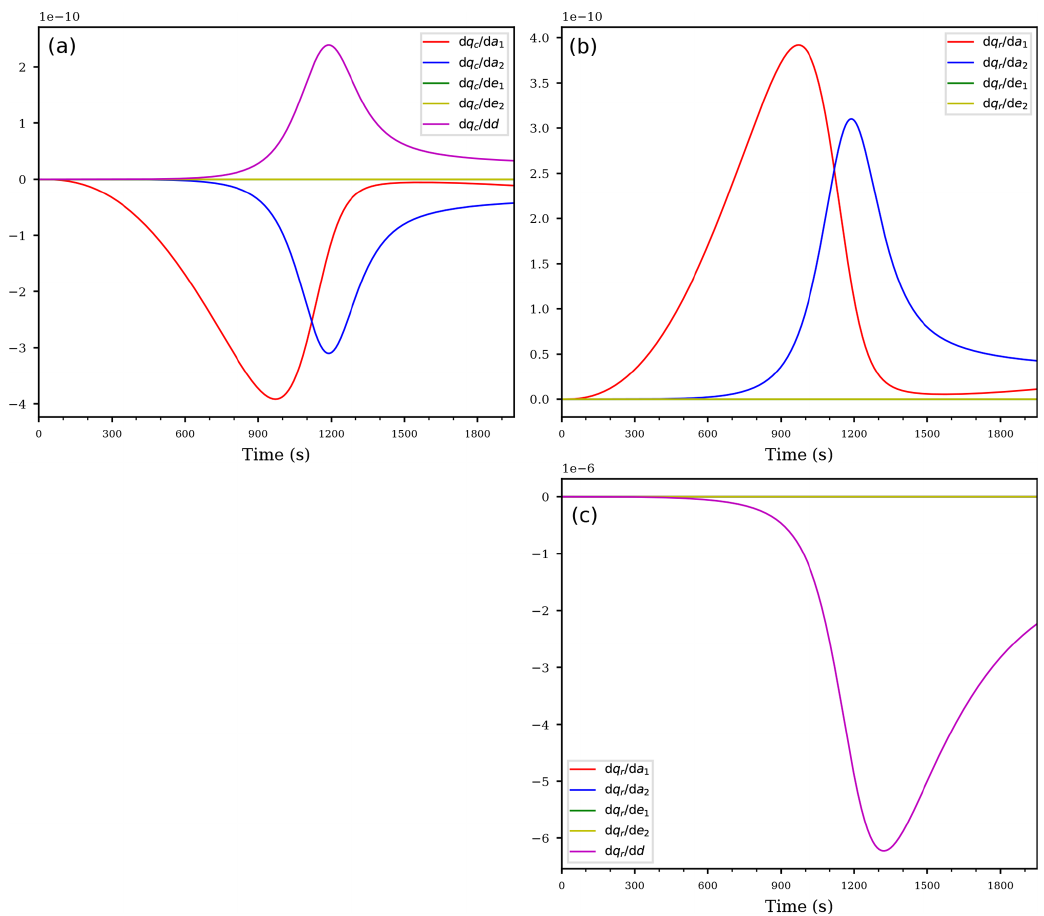
Figure 2. Temporal evolution of the derivatives of the cloud droplet mixing ratio q c (a) and the derivatives of the rain drop mixing ratio q r (b) and (c) with respect to the coefficients. Panel (b) shows the derivatives of the rain drop mixing ratio q r with respect to the coefficients but without the derivative ∂q r with respect to the sedimentation coefficient; the panel (c) shows the derivatives of q r including the derivative with ∂d respect to the sedimentation coefficient d (purple curve). All panels correspond to the first case of an ascending air parcel with no pre-existing clouds. ple curve Fig. 2a, representing the derivative ∂q c of the ∂d